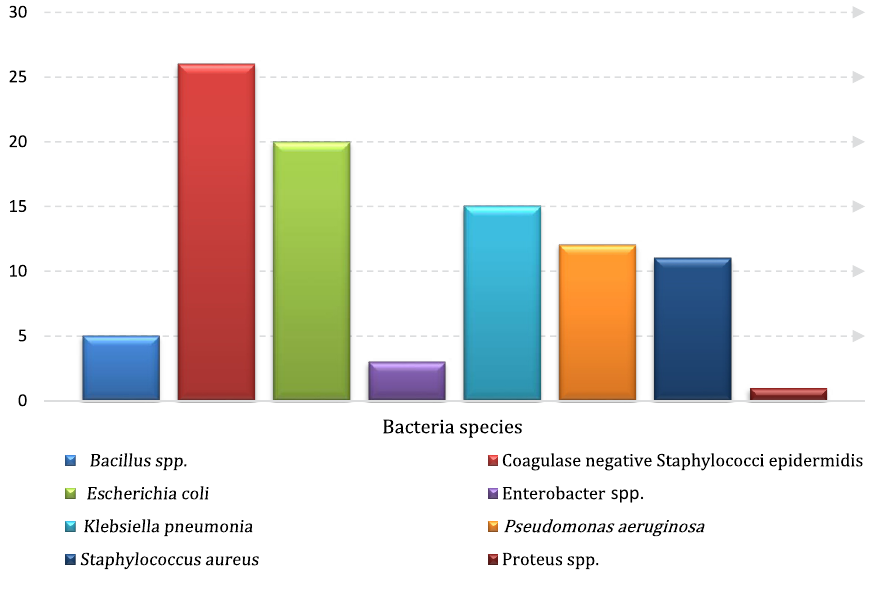
Fig. 1. Bacteria species that isolated from personal cell phones